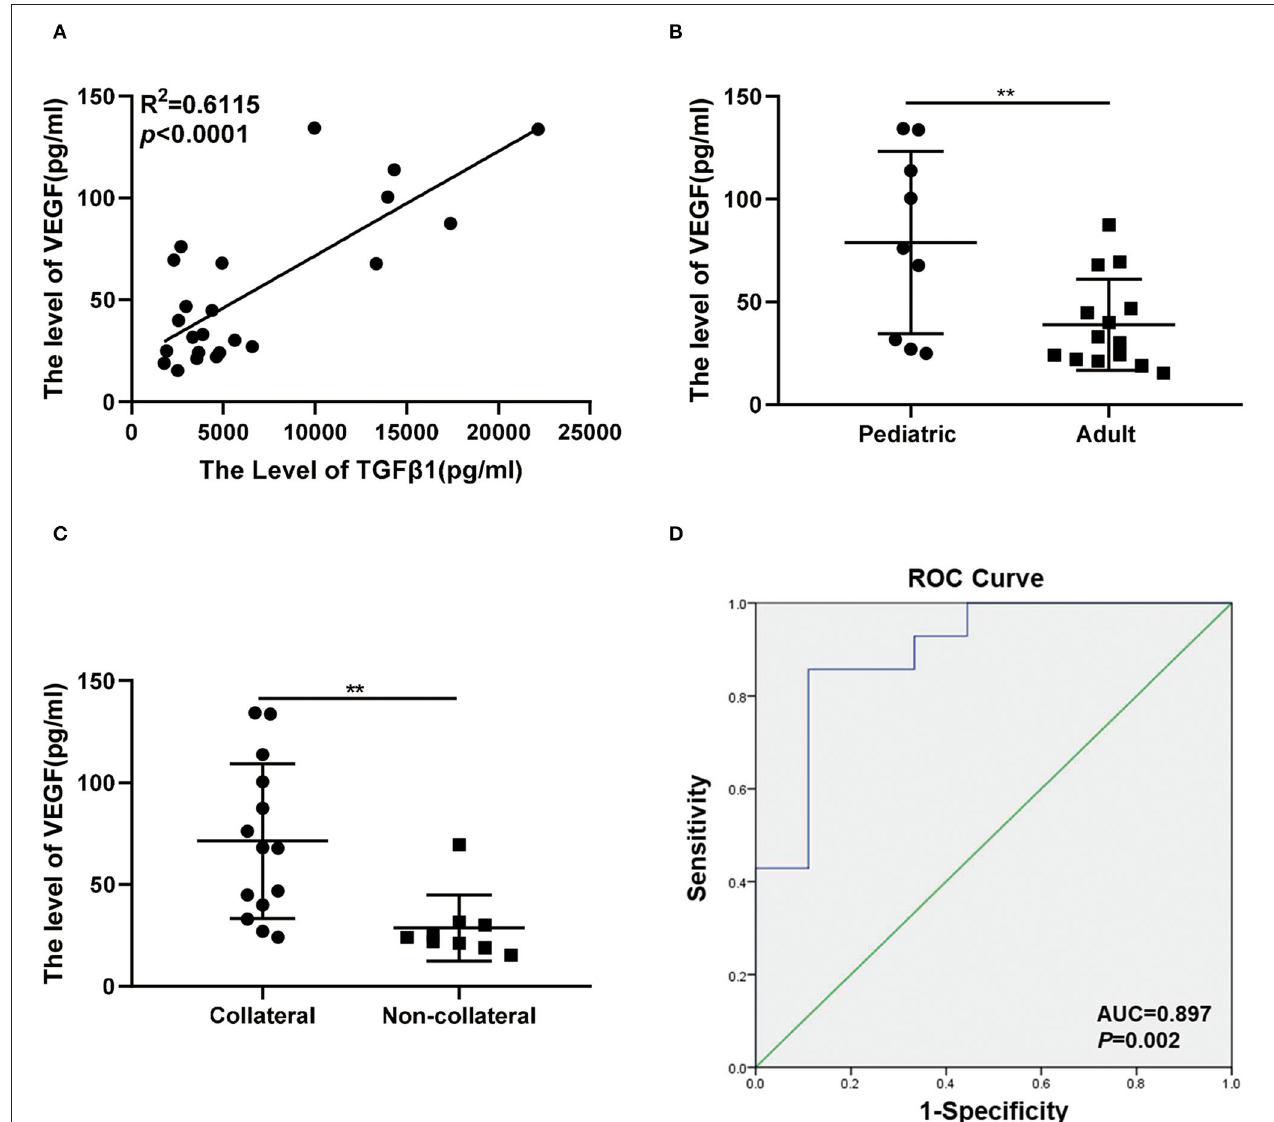
FIGURE 4 | Association between VEGF and transdural collaterals in MMD. (A) The levels of TGF β 1 was correlated with VEGF in plasma of MMD under the linear regression analysis. (B) There was a higher level of VEGF in pediatric group ( n = 9) than the adult group ( n = 14). (C) The expression level of VEGF between collateral group ( n = 9) and non-collateral group ( n = 14). (D) The ROC curves were used to assess the value of the VEGF and predict the collateral formation. ** p <